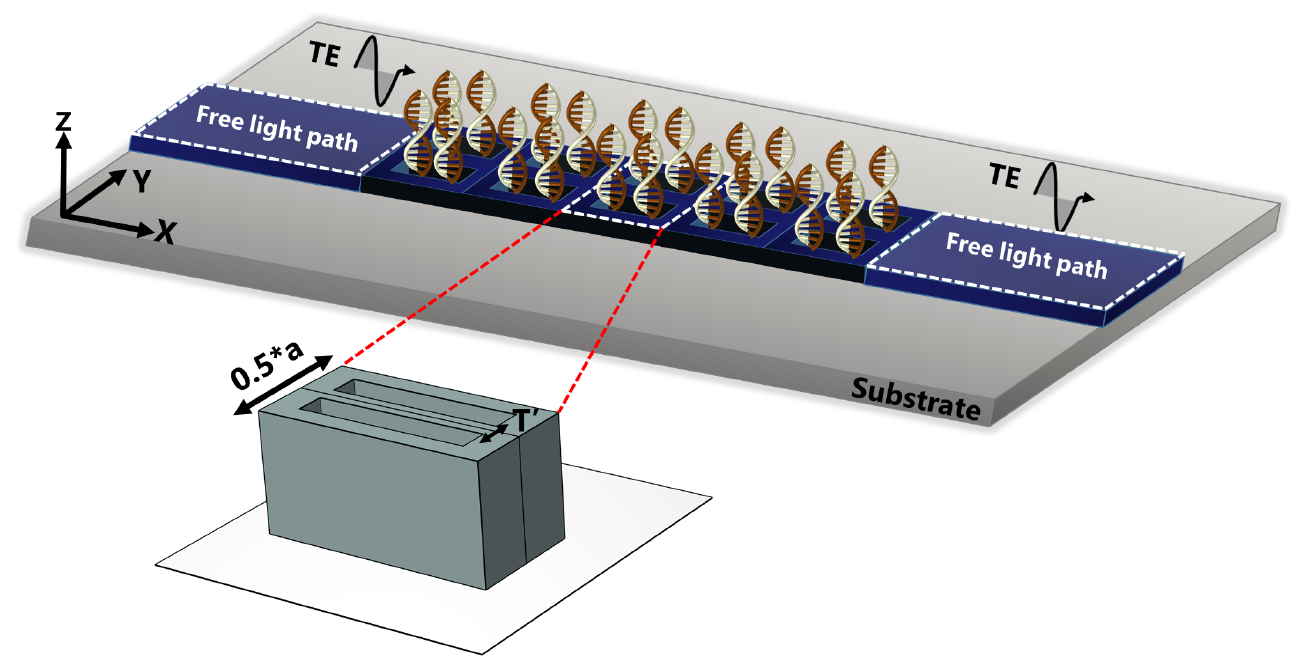
Figure 2. Illustration of the transmission measurement procedure that entailed irradiating the dimer PhC with a TE-polarized wave traveling from the left along the Γ X direction of the irreducible Brillouin zone, the energy is recorded at the right side for different stages of DNA